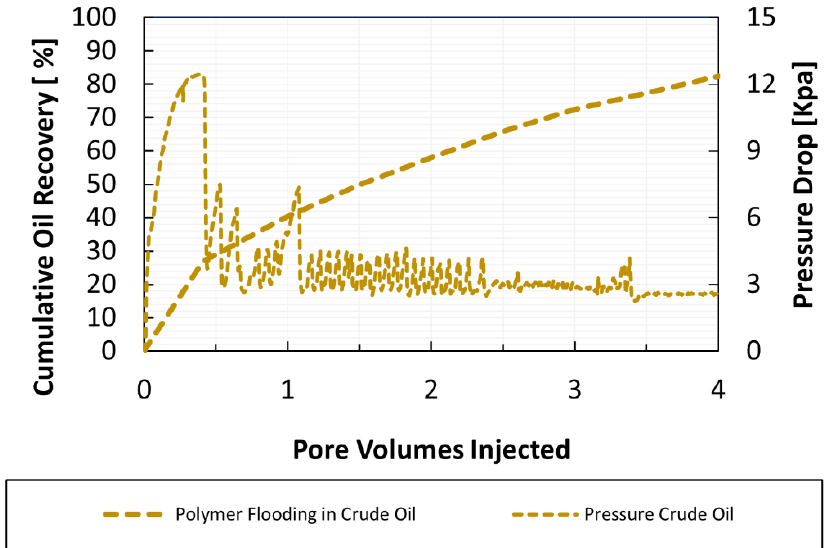
Figure 11. Oil recovery by polymer flooding for crude oil.